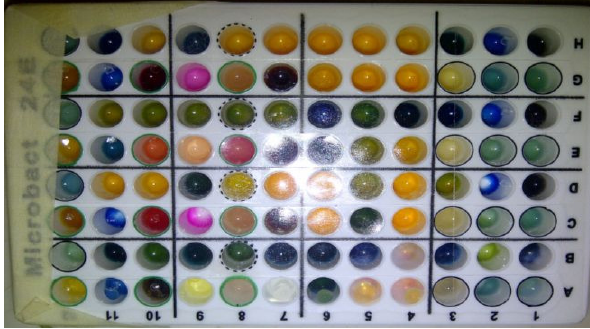
Plate 1. Microbact wells before and after inoculation with organisms